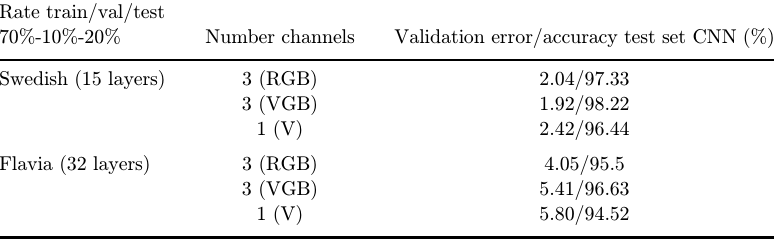
Table 3. Experiment results for CNN model (where V is the channel with extracted image of leaf veins).